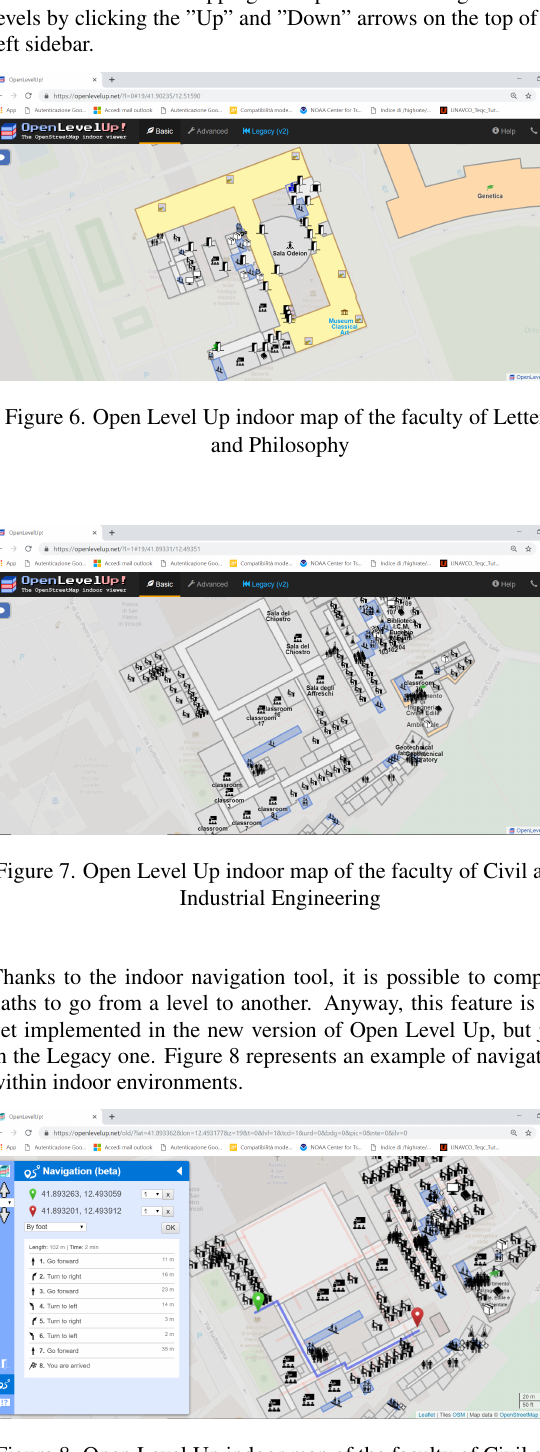
Figure 8. Open Level Up indoor map of the faculty of Civil and Industrial